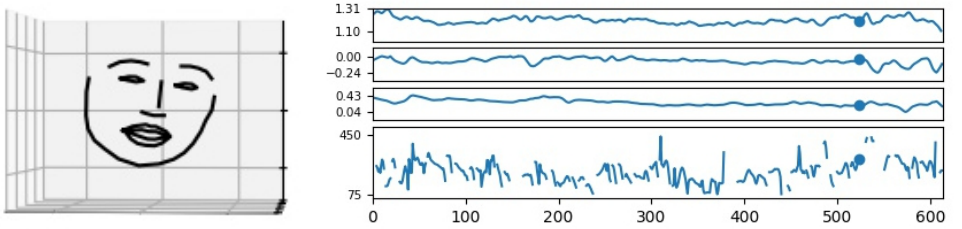
Figure 1. A frame with 3D facial landmark annotation (left) and measurements of eyebrow height, sagittal head angle, lateral head angle, and pitch; the segment has been taken from Episode 0148 featuring Art Donovan. Original frames are not shown for reasons of